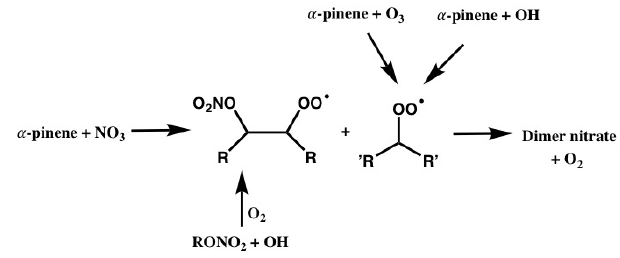
Figure 9. Schematic of the proposed chemical mechanism respon- sible for monoterpene dimer nitrates (those possessing 16 or more carbon atoms with a nitrate functional group) observed in the gas and particle phases during BAECC. The nitrated peroxy radical can be produced either by the NO 3 -radical oxidation of σ -pinene or by the OH-radical oxidation of σ -pinene